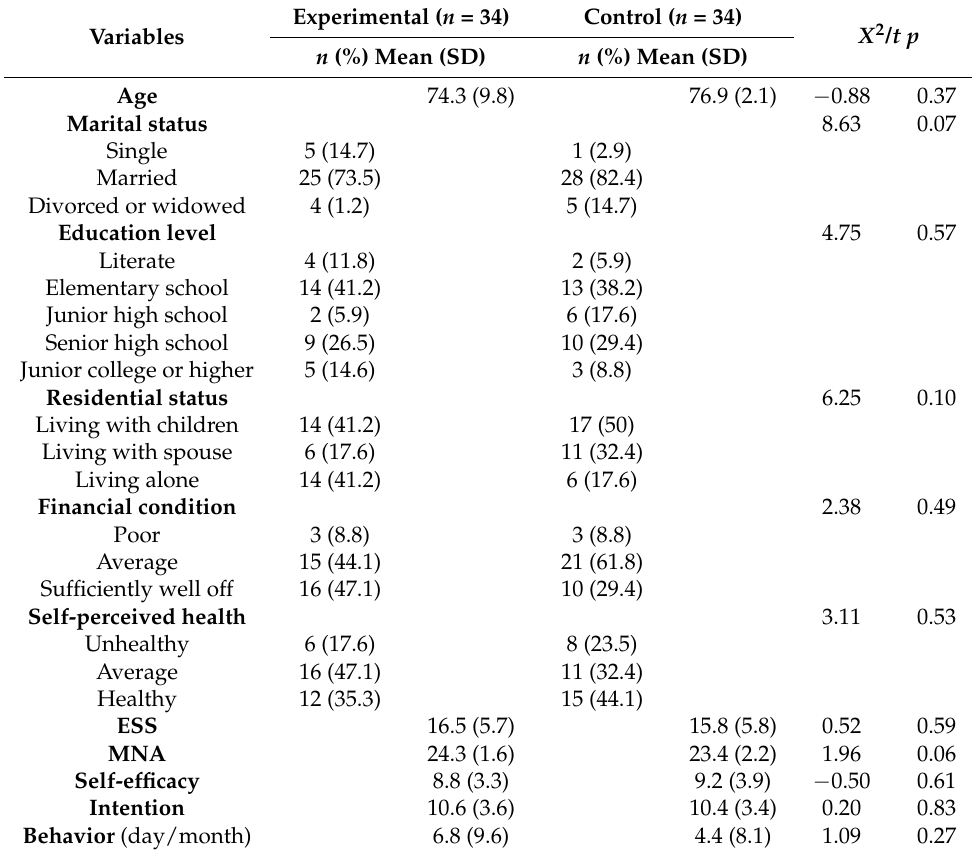
Table 2. Summary of personal characteristics by group in the baseline ( n = 68).